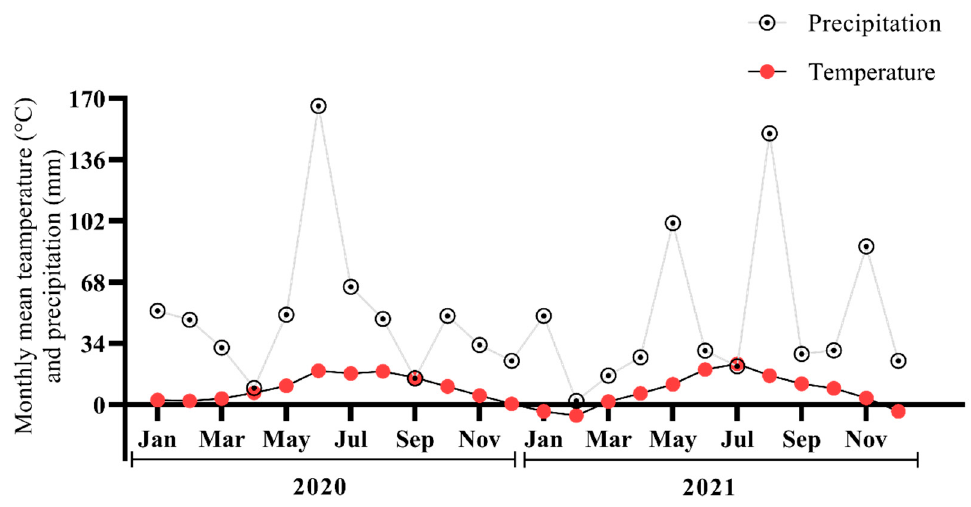
Figure 1. Mean monthly precipitation (mm) and air temperature (°C) during 2020 and 2021. Table 1. Physiochemical properties of soil and biochar and soil chemical changes during two years.